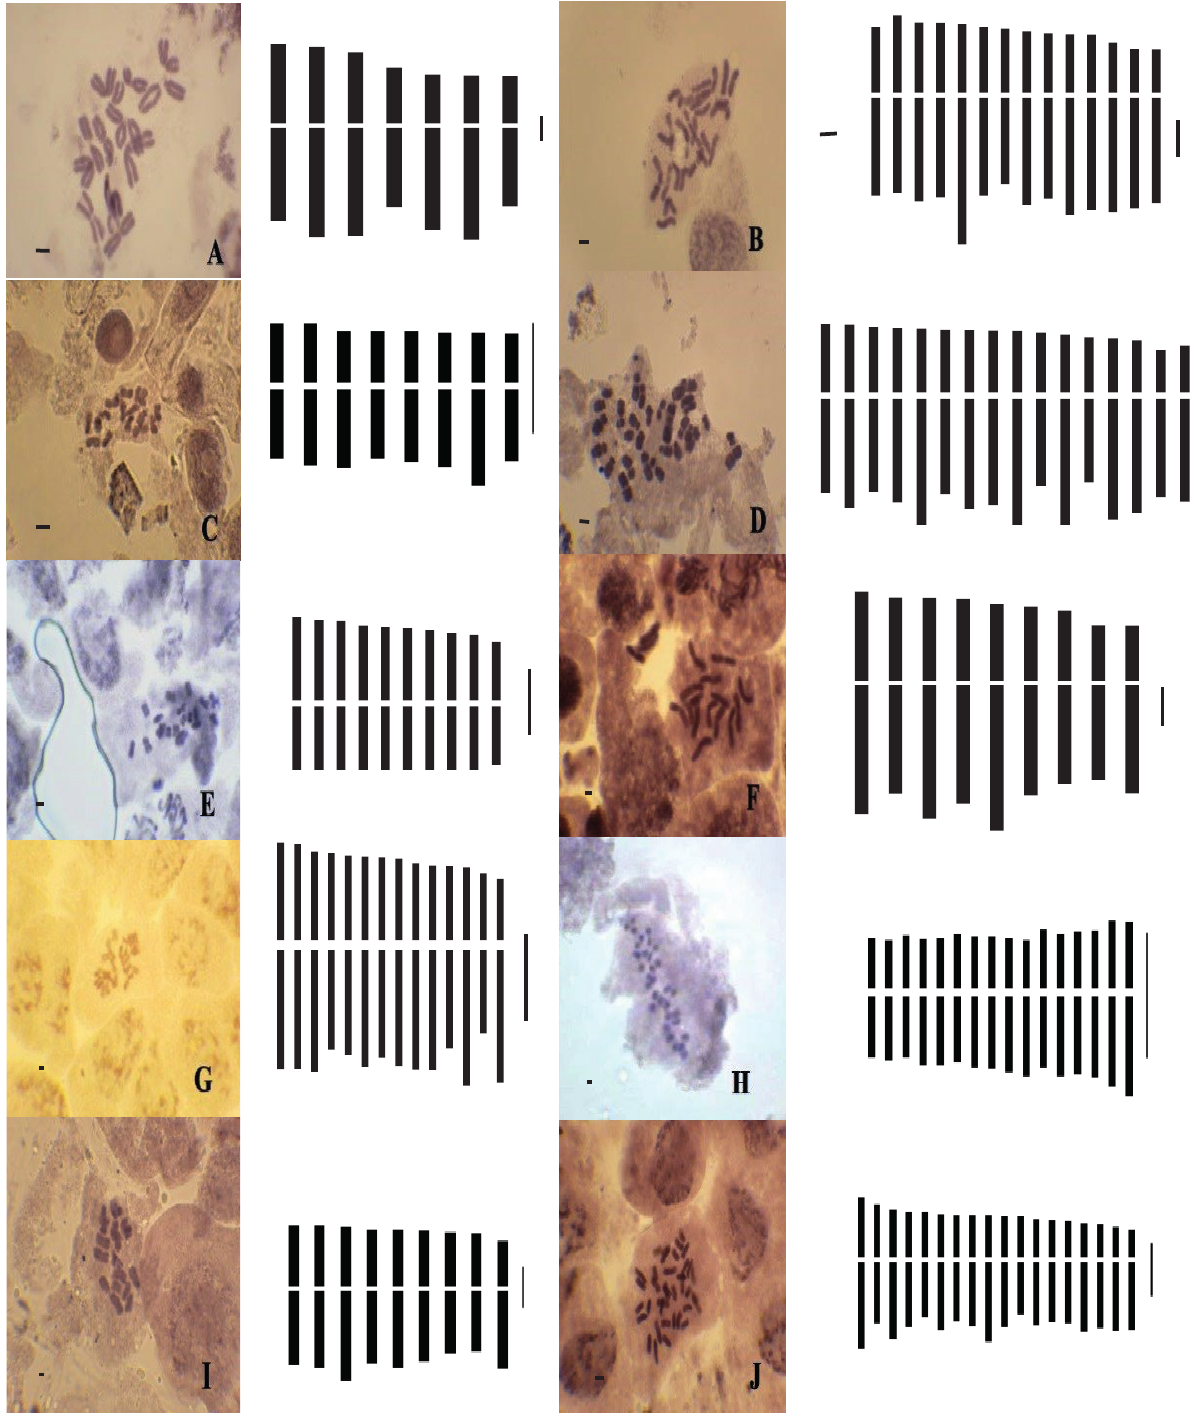
Figure 1. Somatic metaphase chromosome, Ideogram of each population is on the right side of the image: A: Alisma plantago- aquatica (2